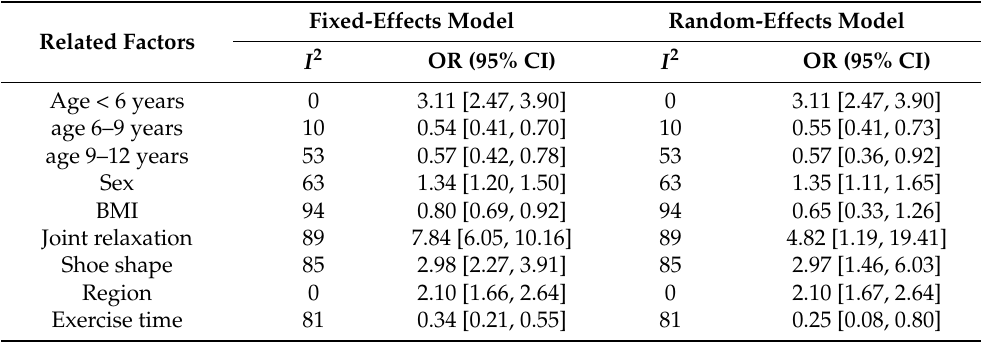
Table 3. Sensitivity analysis of related factors for flatfoot in children.